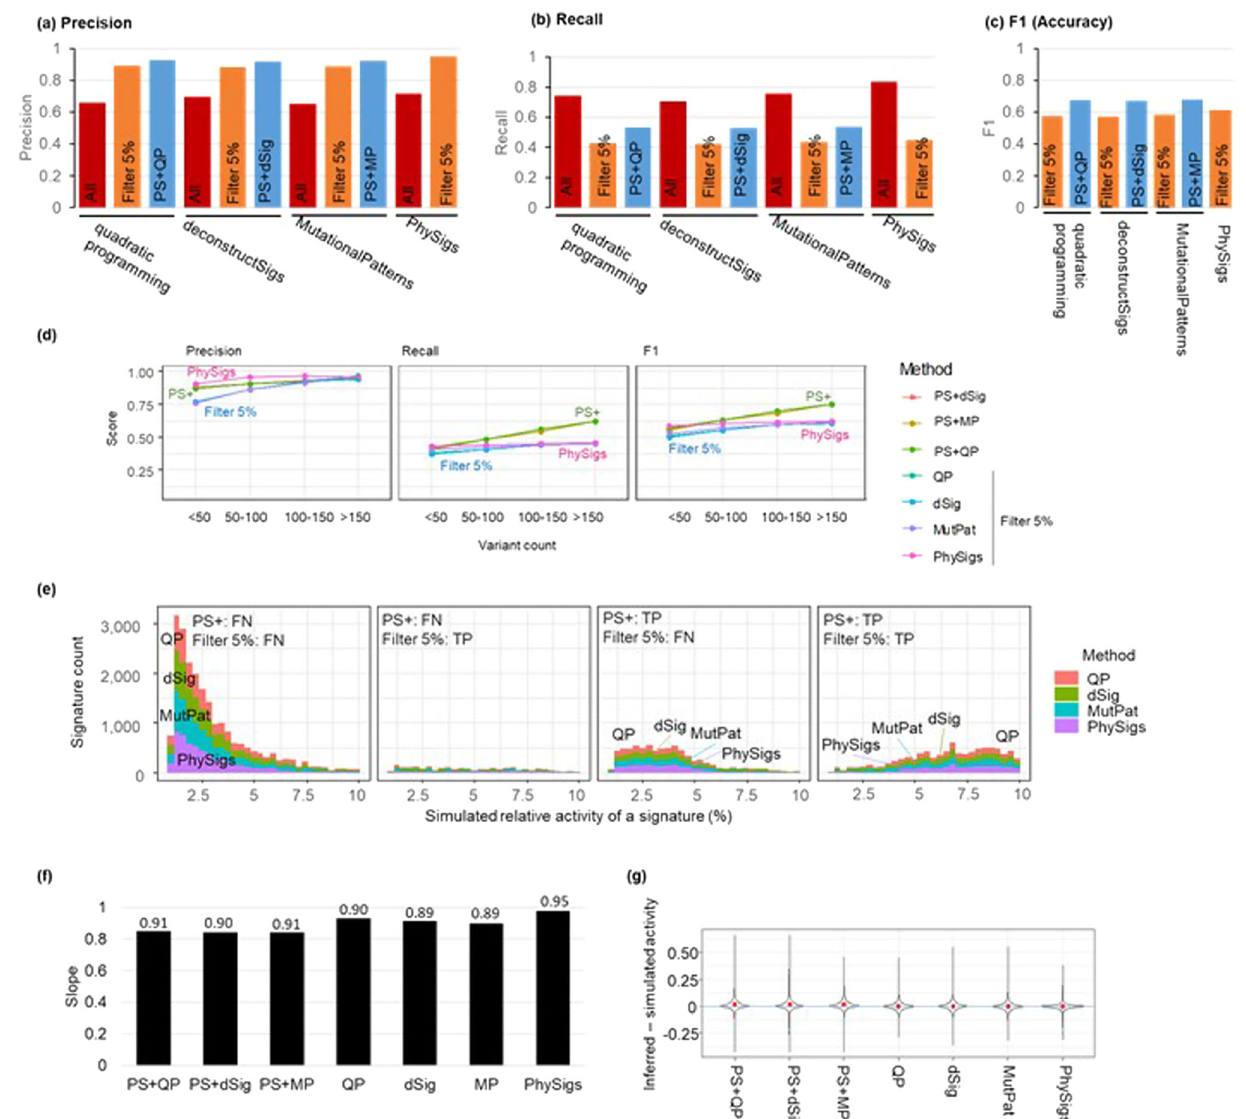
Fig. 4 The performance of PhyloSignare. a Precision, ( b ) recall, and ( c ) F1 score for all the signatures across all datasets for QP, deconstructSigs (dSig), and MutationalPatterns (MP) without (red) and with PhyloSignare (PS) approach (blue, PS + QP, PS + dSig, and PS + MP, respectively), PhySigs, and those with removing signatures with <5% estimated relative activity (orange). Signatures were pooled across all datasets in the computation. Precision was computed as the number of correct signatures detected divided by the total number of signatures detected. The recall was the number of correct signatures detected divided by the total number of simulated signatures. F1 = 2× Precision×Recall/(Precision + Recall). d Performance was compared among various numbers of variants per branch. The 5% fi ltering was applied for all the methods except for PS. e Detection of faint signatures (<10% simulated relative activities) was compared between PhyloSignare and the other methods (QP, dSig, MutPat, and PhySigs) with fi ltering out signatures with low inferred relative activities (<5%). f Regression slopes between the simulated and inferred activity of signatures. The number above a bar is the R 2 of the statistical fi t. g The difference between inferred and simulated activities of correctly identi fi ed signatures (average marked by red